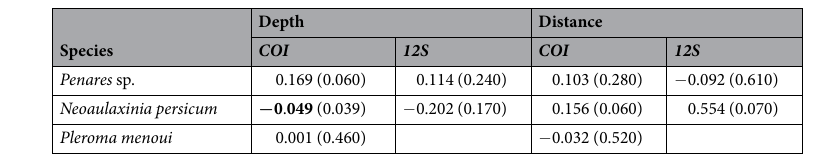
Table 3. Mantel tests of isolation-by-depth and isolation-by-distance amongst different markers and species. Values shown as correlation coefficient (p value). Numbers with bold mean significant isolation. Poecillastra laminaris was not tested because of pronounced genetic structure at different spatial